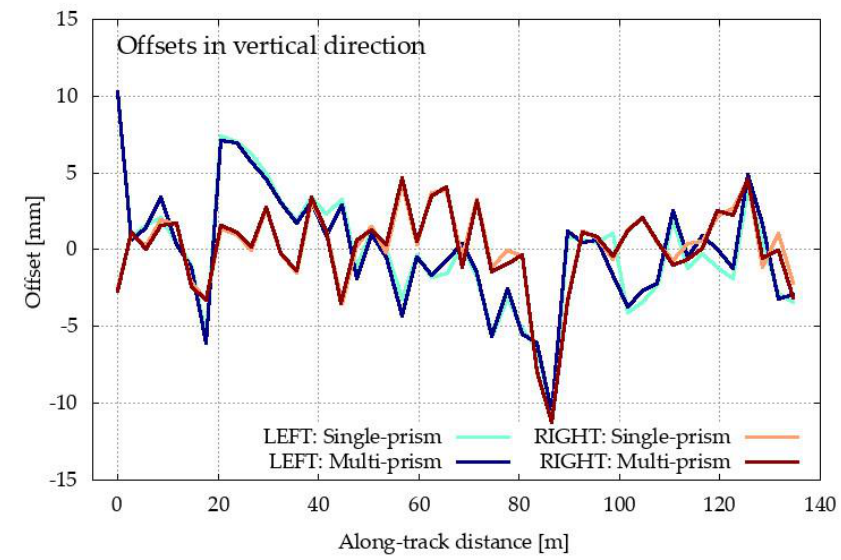
Figure 14. Offsets of the determined characteristic point 𝐂 from its designed value in the vertical direction for both methods (single- and multi-prism) and both inrun tubes (left and right).